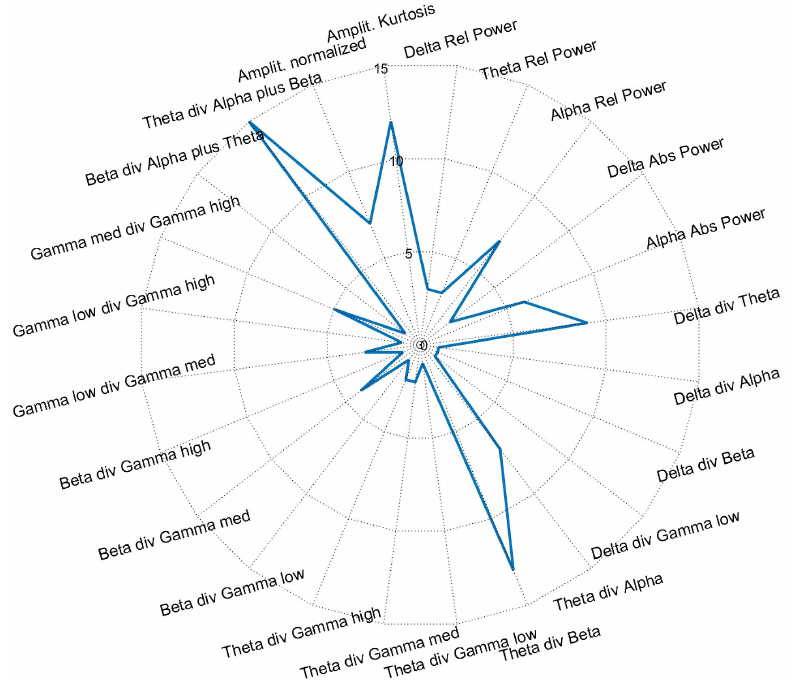
Figure 9. Radar plot depicting which type of features are more frequent (in %) in the dataset obtained after feature selection, for the multiclass scenario C1 vs. C2 vs. C3 vs.